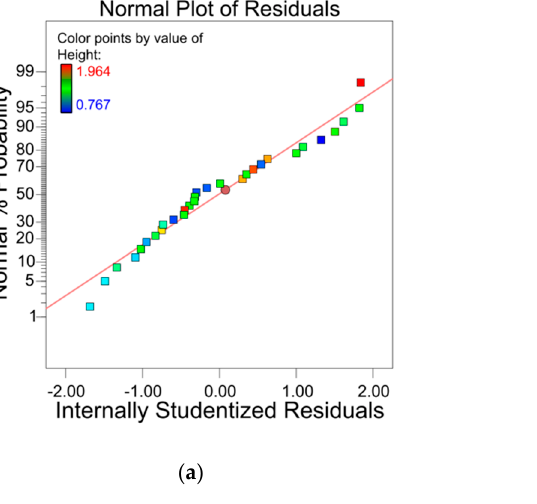
Figure 9. ( a ) Clad height model plot of residuals. ( b ) Clad height model prediction and actual comparison.